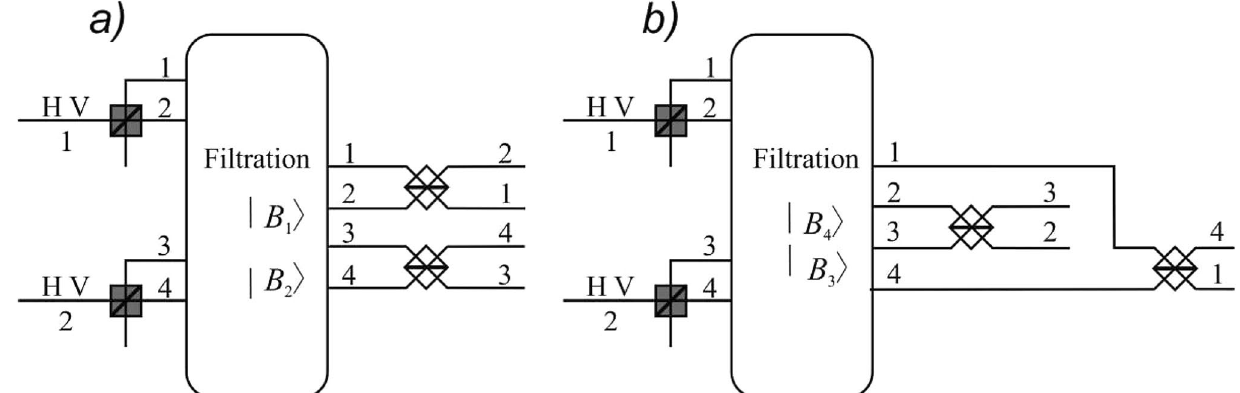
Figure 1. Principle scheme for Bell state measurement with filtration operation based on non-demolition filtration. With grey and white colours polarization and 50:50 beam splitters are denoted respectively. The filtering operation is described with Eqs. (11)–(12), respectively. The unitary transformations for the states B B B B , , ( a ) and ( b ) according to the classical bit of information are 1 2 3 4 | � | � | � | �